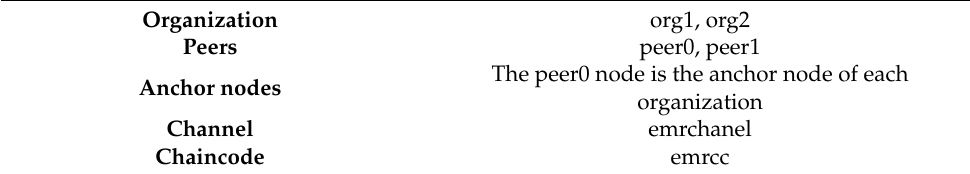
Table 2. Blockchain network deployment.